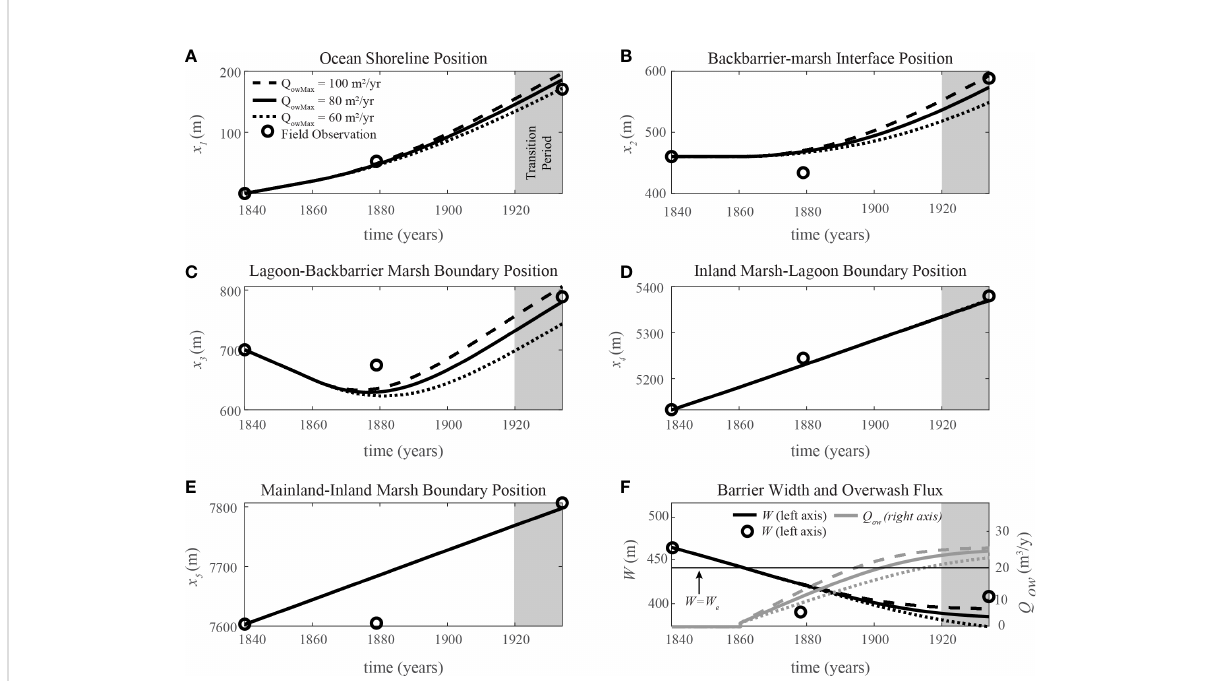
FIGURE 5 Evolution of the geomorphic moving boundaries (panels A – E ) with landward directed migration assumed to be positive, and overwash fl uxes and barrier width (panel F ), during phase 1. Sensitivity of barrier-in fl uenced geomorphic boundaries to variations in maximum overwash are indicated for rates of 60, 80, and 100 m 2 /yr. See Figure 4B for a schematic of model geometry that includes the boundaries being tracked, x 1 to x 5 . The input parameter values are included in Supplementary Table